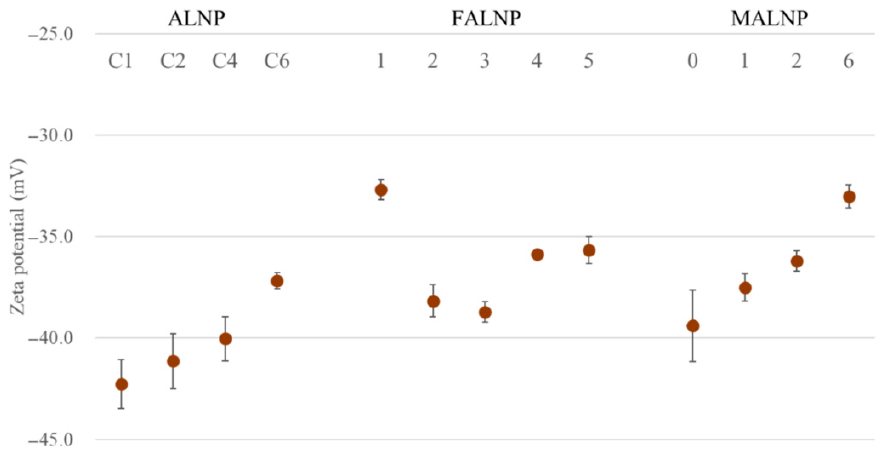
Figure 4. Zeta potential values of ALNPs as functions of various conditions.